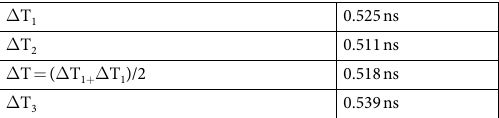
Table 1. Delay time through PCs with different